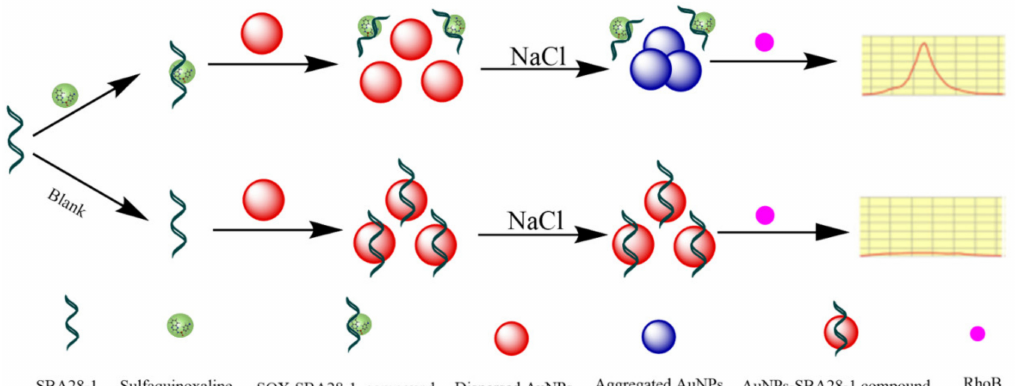
Figure 4. Schematic illustration of the fluorescent aptasensor for detecting SQX based on label-free aptamer and the FRET between RhoB and